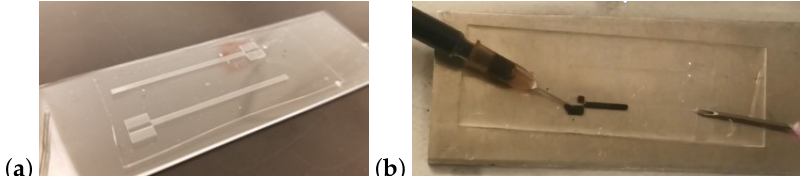
Figure 10. ( a ) Two PDMS pieces sealed together to form the dielectric part of the stacked DEA structure before injecting the c-PDMS in Method III. ( b ) Injection of c-PDMS. The needle on the right-hand side of (b) is placed at the bottom end of the sealed device to let the air out easily from inside the hollow channels into the vacuum